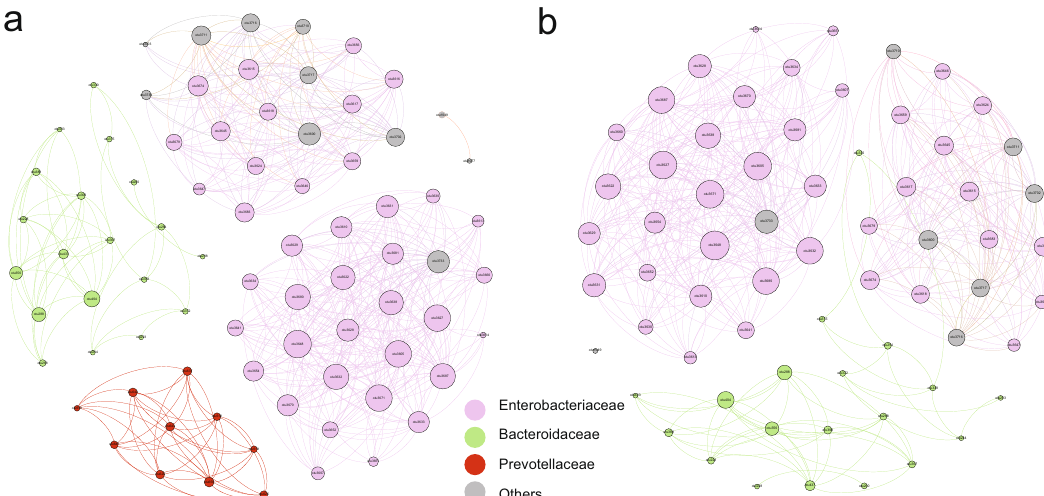
Fig. 2 Co-occurrence networks. Co-occurrence networks were calculated based on Spearman correlations at the operational taxonomic unit (OTU) level. The more connections, the larger the node (degree). Only strong ( r > 0.7) and signi fi cant ( p < 0.05) correlations are shown in the fi gure and nodes with few connections (<5) were removed. a Healthy controls. b Patients with Parkinson ’ s disease (PD). Nodes were colored by